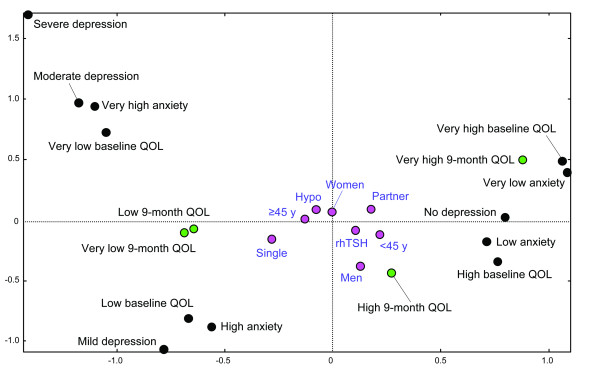
Multiple correspondence analysis (MCA), plane of the first two factorial axes (factor 1 and factor 2) representing relationship with the 9-month QOL Green circles: 9-month QOL (very low/low/high/very high); Black circles: anxiety (very low/low/high/very high), depression (no/mild/moderate/severe), baseline QOL (very low/low/high/very high); Pink circles: patients' parameters; single/partner, <45y/> = 45y, men/women, hypo/rhTSH.